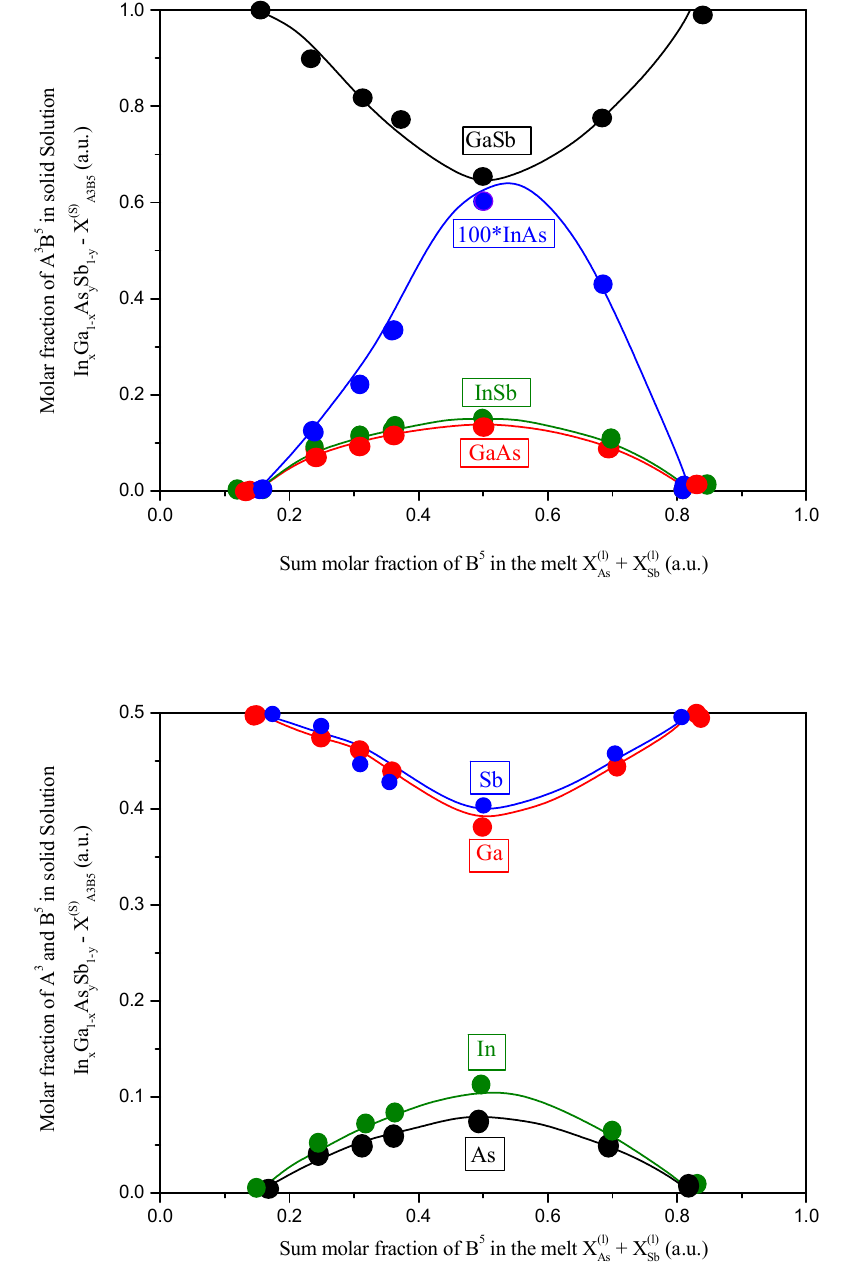
Figure 1. Molar fraction of components A 3 ( In, Ga) and B 5 ( As, Sb), top fragment, compounds A 3 B 5 (InAs, InSb, GaAs, GaSb), and bottom fragment in solid solution In x Ga 1/2-x As y Sb 1/2-y (isoperiodic to the substrate GaSb )— X (s) , depending on the sum molar fraction of B 5 components in the equilibrium to solid solution melt: X at T = 873 K and P = 1 atm. (Points are experimental data, lines are calculated by EFLCP model for A 3 -B 5 semiconductor systems [13,14].